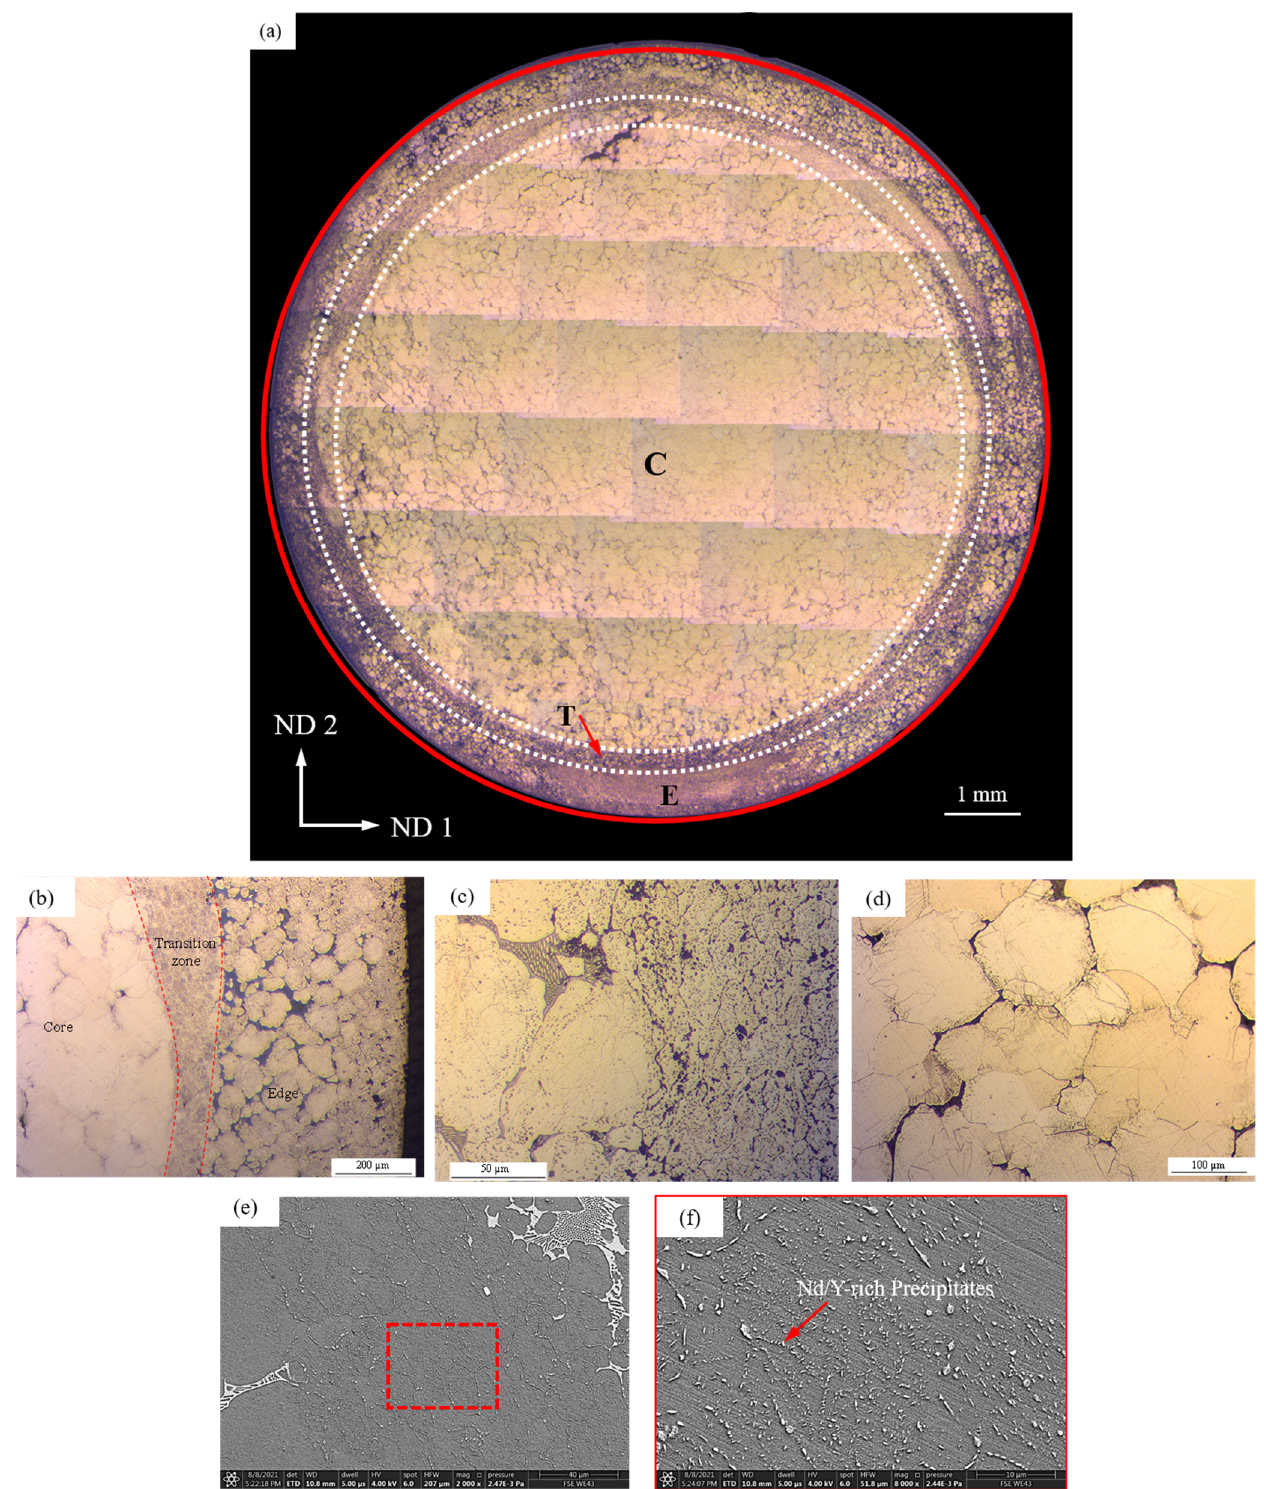
Figure 3. ( a ) Collage of OM images showing WE43 Mg alloy extruded rod overall macrostructure. Optical micrographs showing ( b ) three distinct regions, ( c ) edge, ( d ) core, and ( e , f ) transition zone.